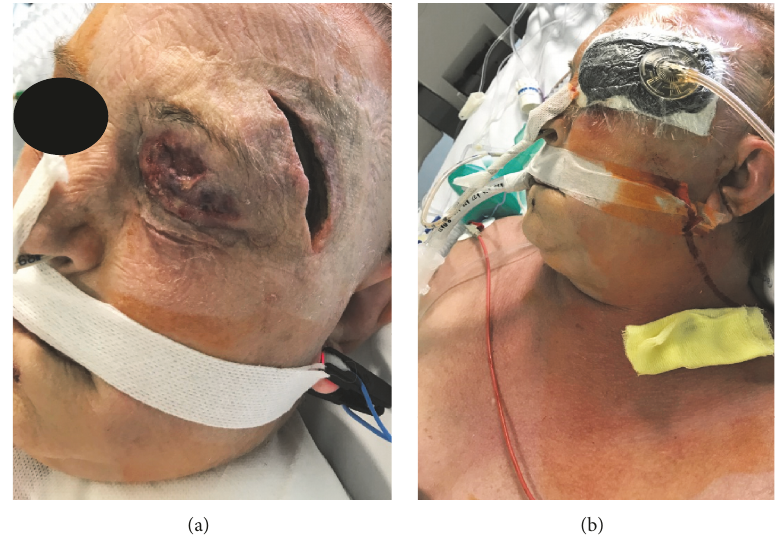
Figure 2: (a) The left frontotemporal surgical incision. (b) NPWT dressings positioned at this